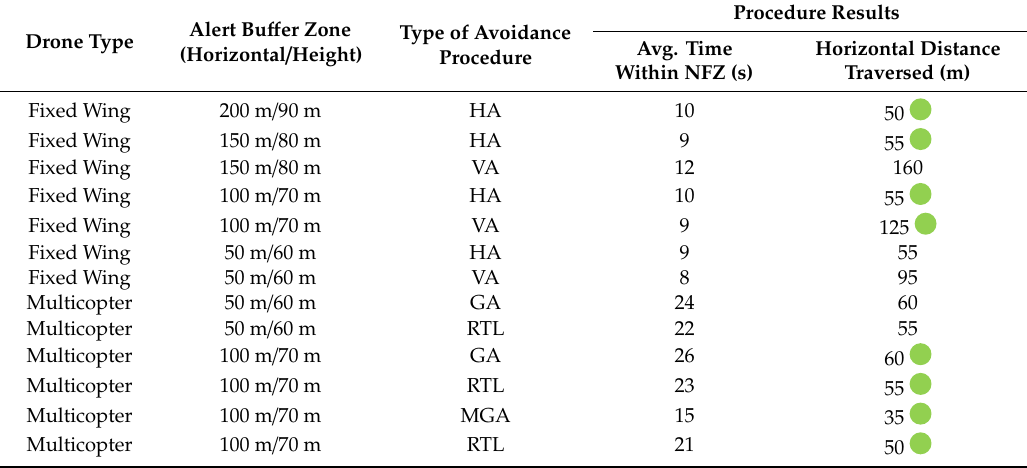
Table 2. NFZ alert distance procedure results for two types of drones: Fixed wing and multicopter. Drone Type